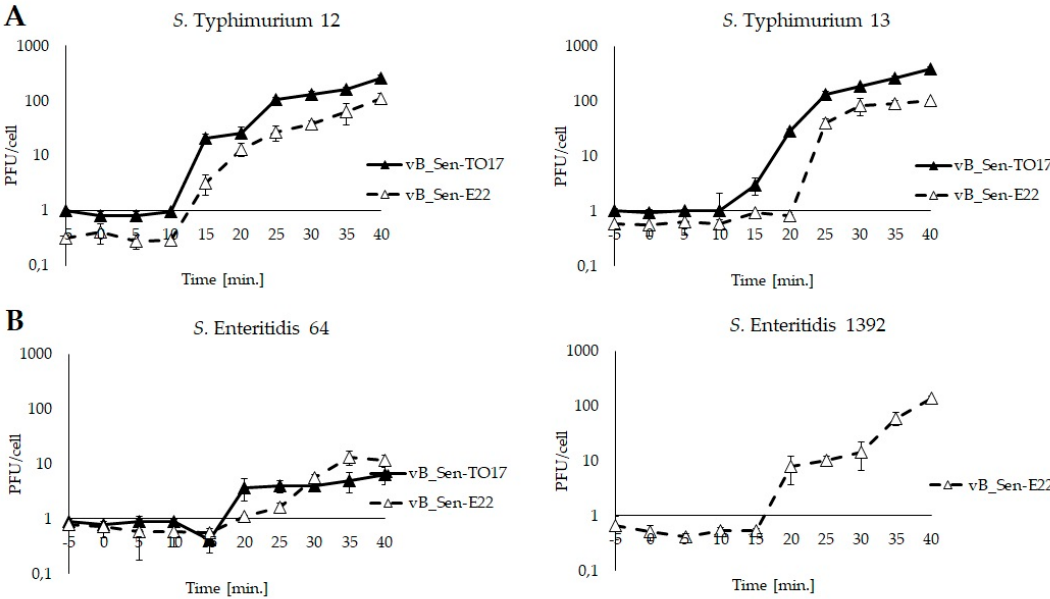
Figure 4. One-step growth experiments with phages vB_Sen-TO17(closed triangles) and vB_Sen-E22 (open triangles) on S. Typhimurium ( A ) and S. Enteritidis ( B ) at 42 °C; m.o.i. = 0.01. Mean values from three independent experiments are shown, with error bars representing SD. Note that S. Enteritidis 1392 is resistant to vB_Sen-TO17 (Table 2); thus, experiments with this strain were performed only for vB_Sen-E22. Table 7. Burst size of phages vB_Sen-TO17 and vB_Sen-E22 on different S. enterica strains at 42 °C. The burst size was calculated from samples untreated with chloroform during the one-step growth experiment. Mean values from three independent experiments with SD are presented.